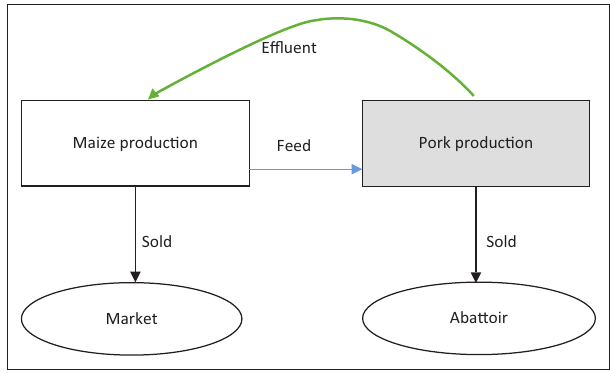
FIGURE 1: Farming operation of Piggery